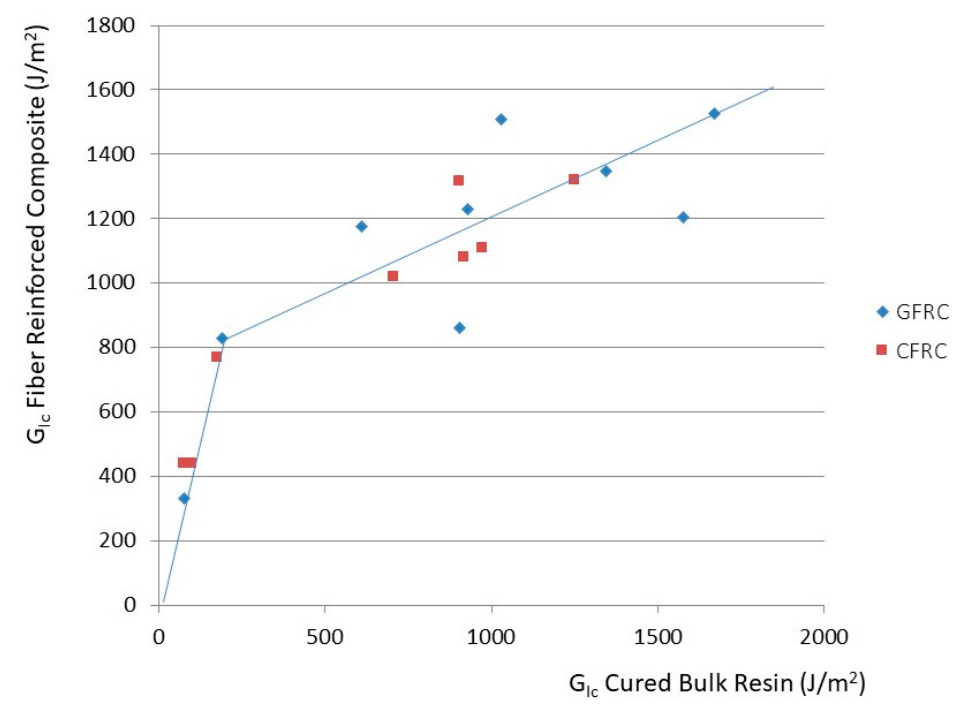
Figure 17. Bulk G Ic versus laminate G Ic of modified epoxy resins [79].